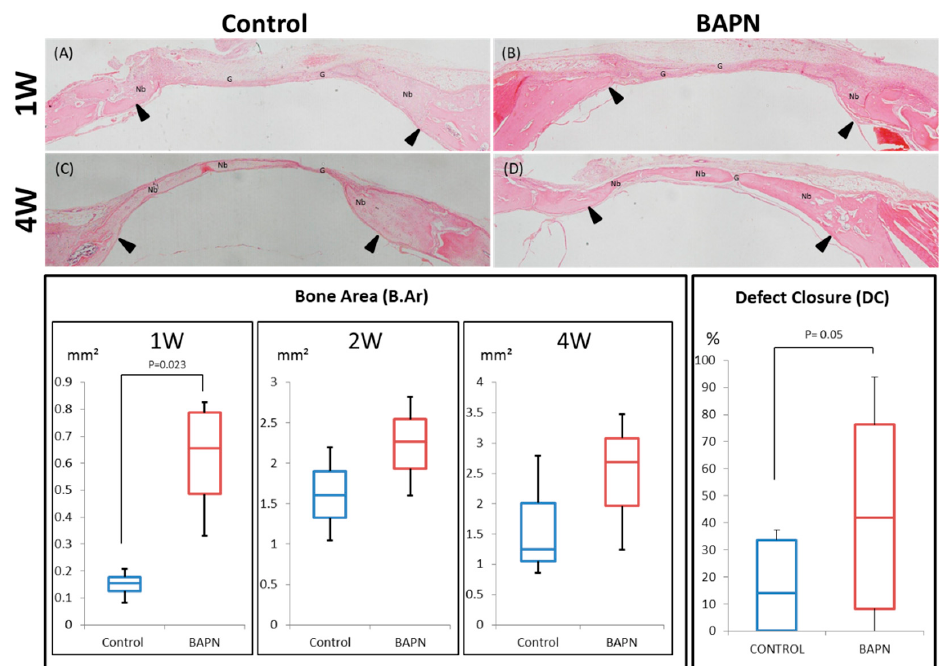
Figure 7. Hematoxylin and eosin staining of the gap area in both groups at Week 4 and B.Ar and DC histomorphometry in box plots. ( A , C ) Control; ( B , D ) BAPN. Black arrowheads indicate the original gap area. BAPN group tends to show higher B.Ar than control at all time points, with a significant difference evident at Week 1. BAPN DC ratio by Week 4 was significantly higher than in control. Nb: New bone; G: Gap. Magnification, ×4.